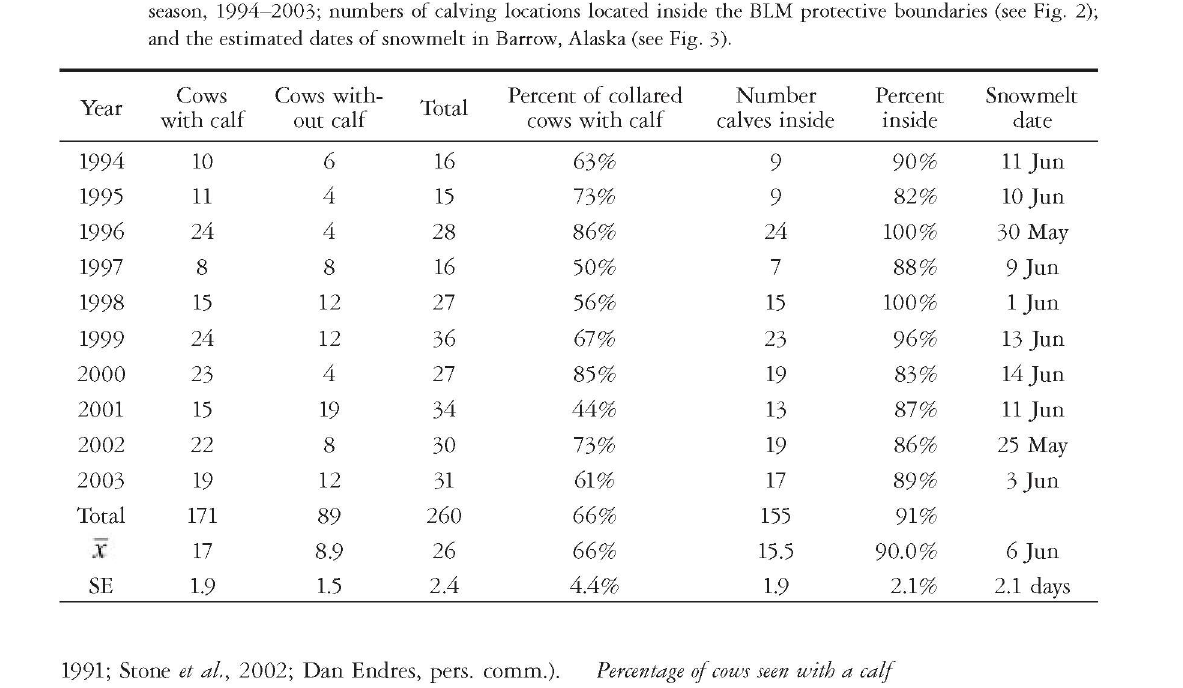
Table 1. Numbers of collared female Teshekpuk Herd caribou seen with a calf or never seen with a calf during calving season, 1994—2003; numbers of calving locations located inside the BLM protective boundaries (see Fig. 2); and the estimated dates of snowmelt in Barrow, Alaska (see Fig.